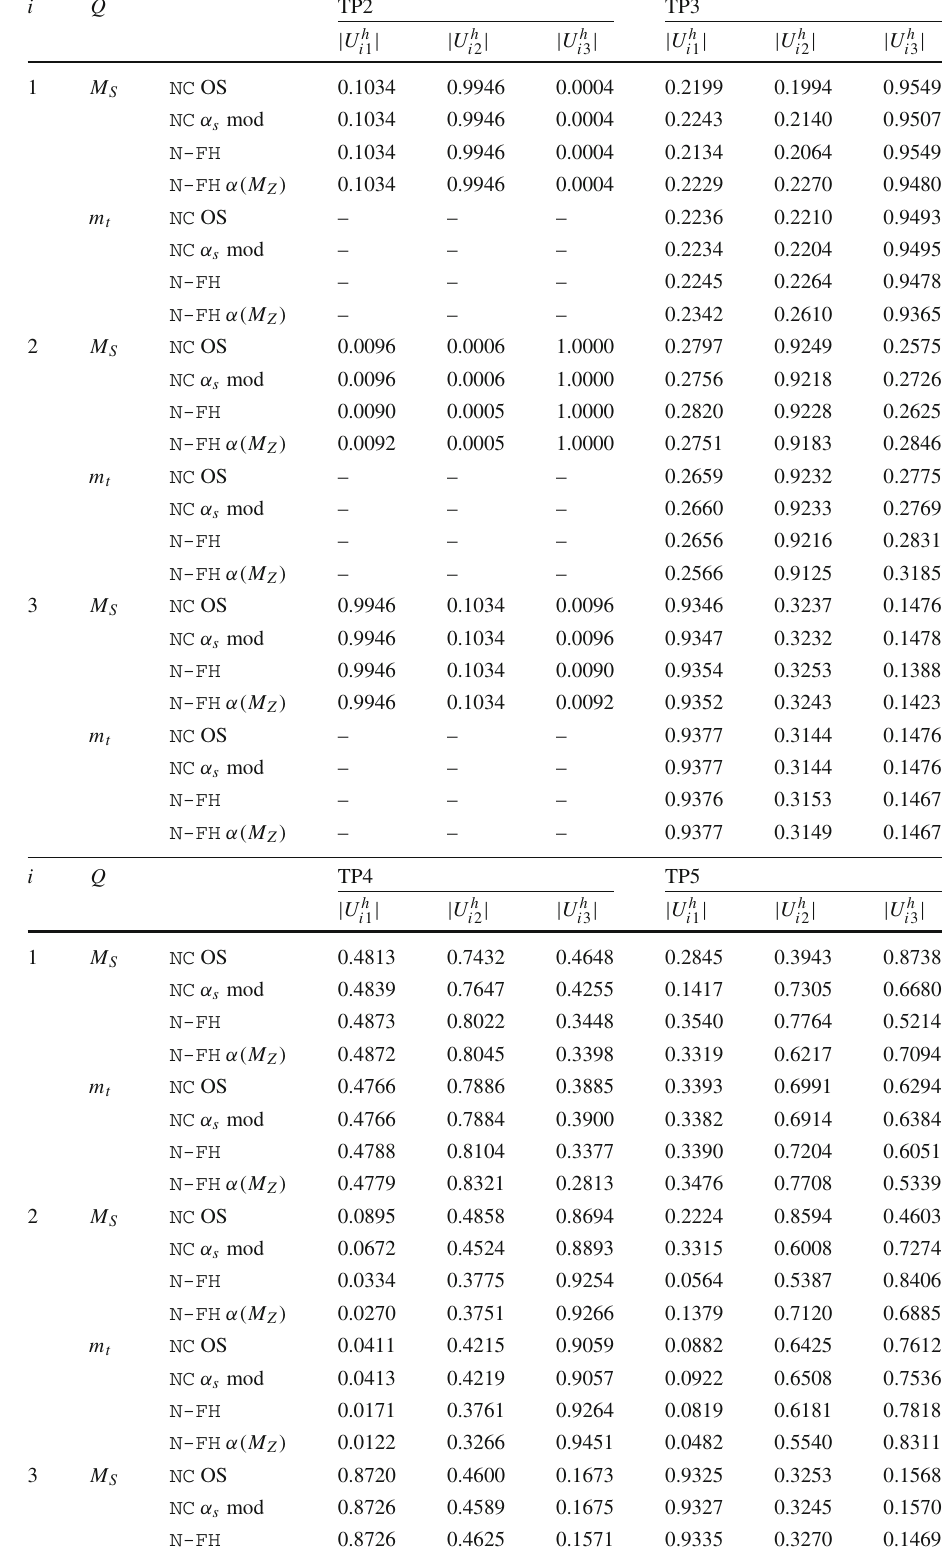
the absolute values for the mixing-matrix elements of the CP -even scalar sector when using the indicated versions of NMSSMCALC and NMSSM-FeynHiggs as specified in Sects. 5.1 and